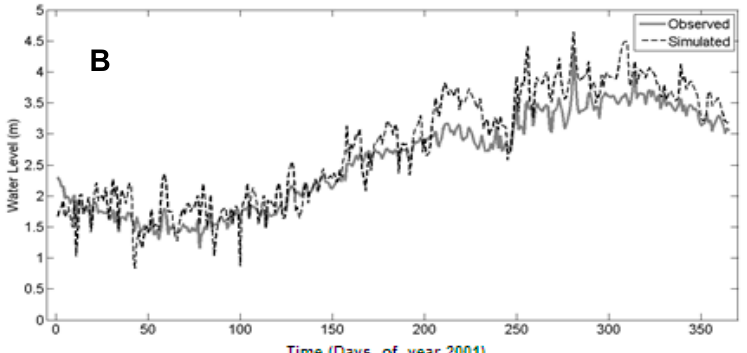
Figure 3. ( A ) Simulated and observed time series of water levels at Santa Izabel (P1) station and ( B ) at Santa Vitória do Palmar (P2) station from January 1, 2001, to December 31, 2001.